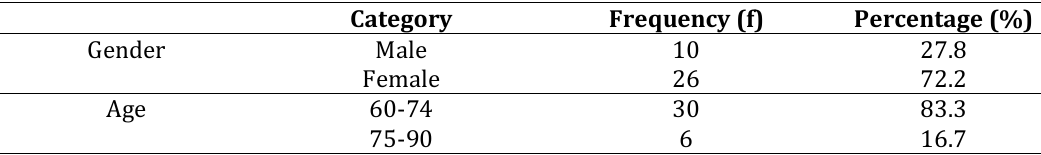
Participant’s Characteristics